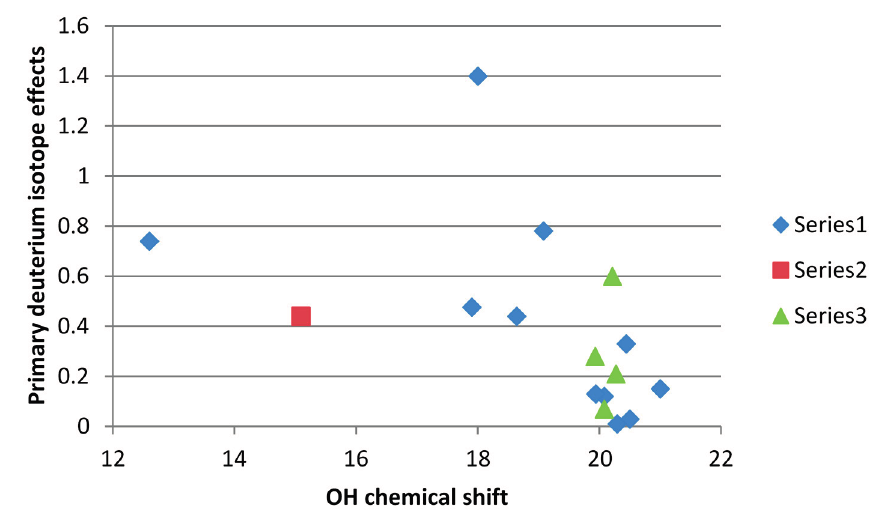
Figure 11. ( A ) cis,cis [4,6-dimethylbenzene-1,3-bis(1,5,7-tris(benzyloxymethyl)-2,4-dioxo- 3-azabicyclo[3.3.1]non-3-yl-7-carboxylic acid)]; ( B ) picolinic acid N-oxide; ( C ) quinaldinic acid N-oxide.